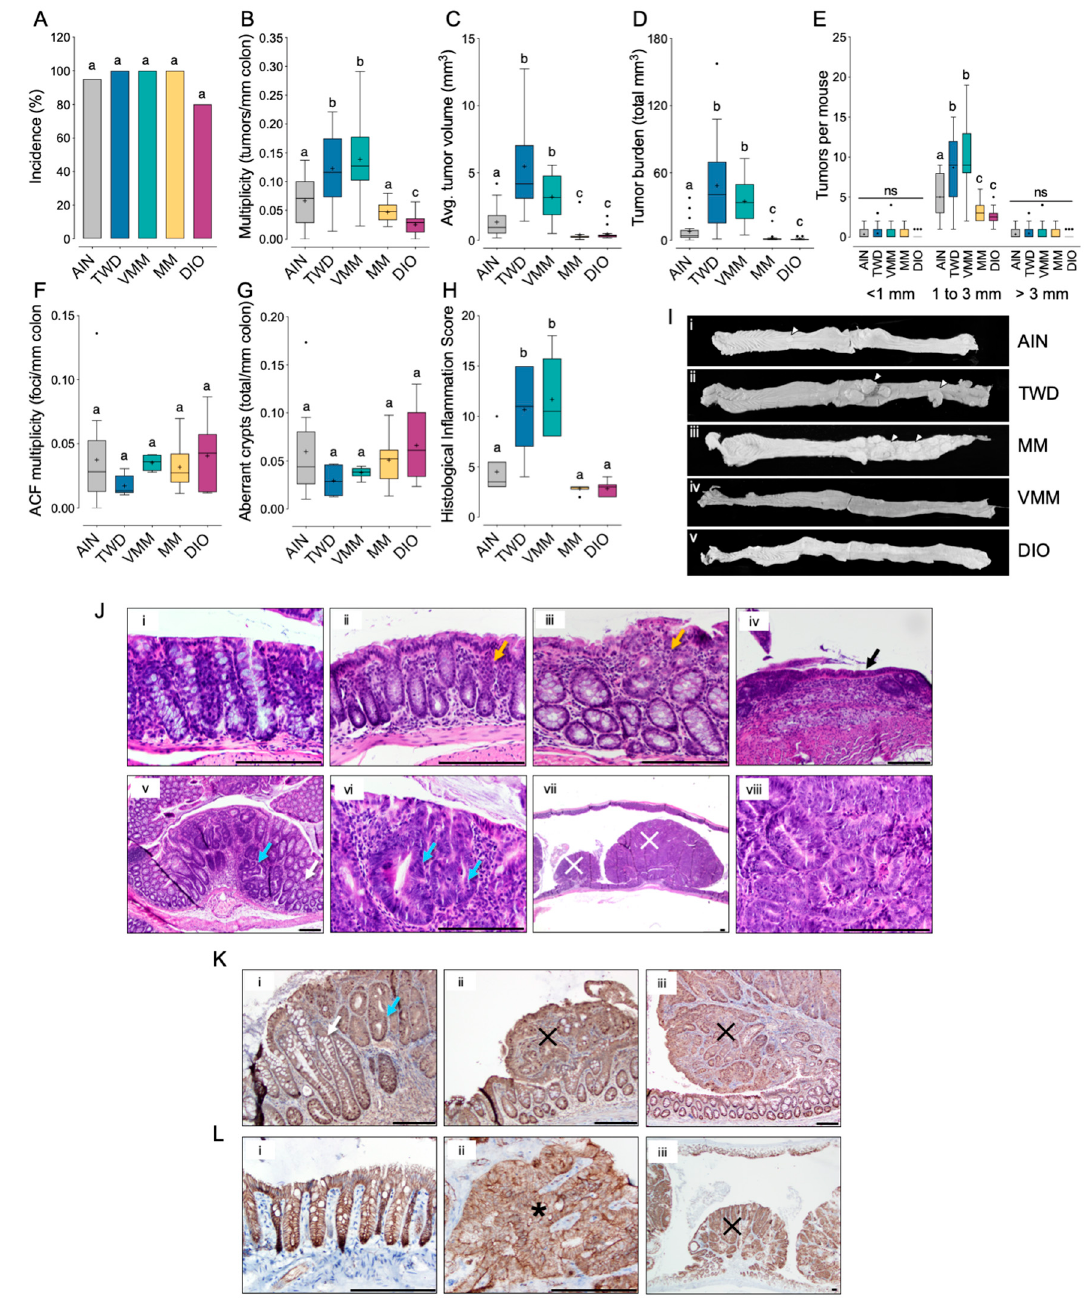
Figure 1. Consumption of the TWD or the vitamin- and mineral-modified diet promoted colon tumorigenesis in a mouse model of inflammation-associated colorectal cancer (Experiment A). C57BL / 6J male mice were fed the standard AIN93G diet (AIN), the total Western diet (TWD), the vitamin- and mineral-modified diet (VMM), the macronutrient-modified diet (MM) or the 45% fat diet-induced obesity diet (DIO). ( A ) Incidence of colon tumors shown as the percent of mice with tumors. ( B–H ) Colon tumor multiplicity ( B ), average tumor volume ( C ), tumor burden ( D ), tumor multiplicity segregated by tumor size ( E ), aberrant crypt foci (ACF) multiplicity ( F ), number of aberrant crypts ( G ), and histological inflammation score ( H ) data are shown as Tukey box plots (box, 25th to 75th percentiles; whiskers, 1.5 IQR; + , mean) ( n = 19 to 20 for tumor endpoints; n = 6 for histological inflammation score). Different letters indicate that diet treatment groups are significantly different ( p < 0.05) as determined by the appropriate linear mixed model or nonparametric test as outlined in the Materials and Methods. For multiplicity data segregated by tumor size ( E ), data were stratified by tumor size prior to statistical analyses. ( I ) Gross pathology images depicting colon tissues representative of each diet treatment group as follows: i, AIN, ii, TWD;